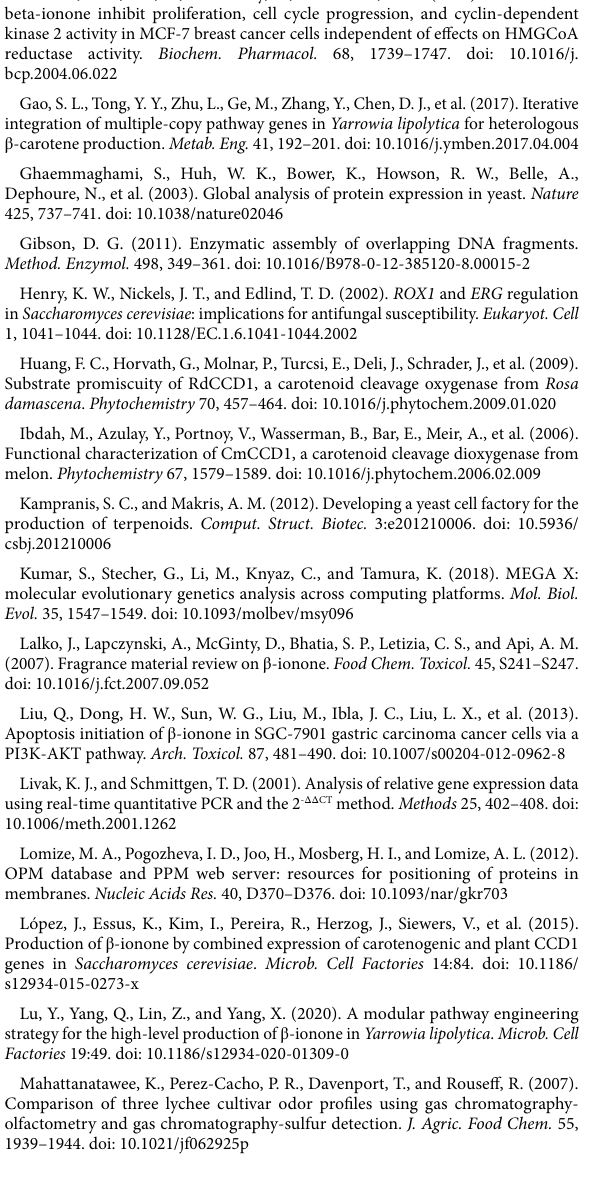
tabacum L.) essential oils. Molecules 24:3446. doi: